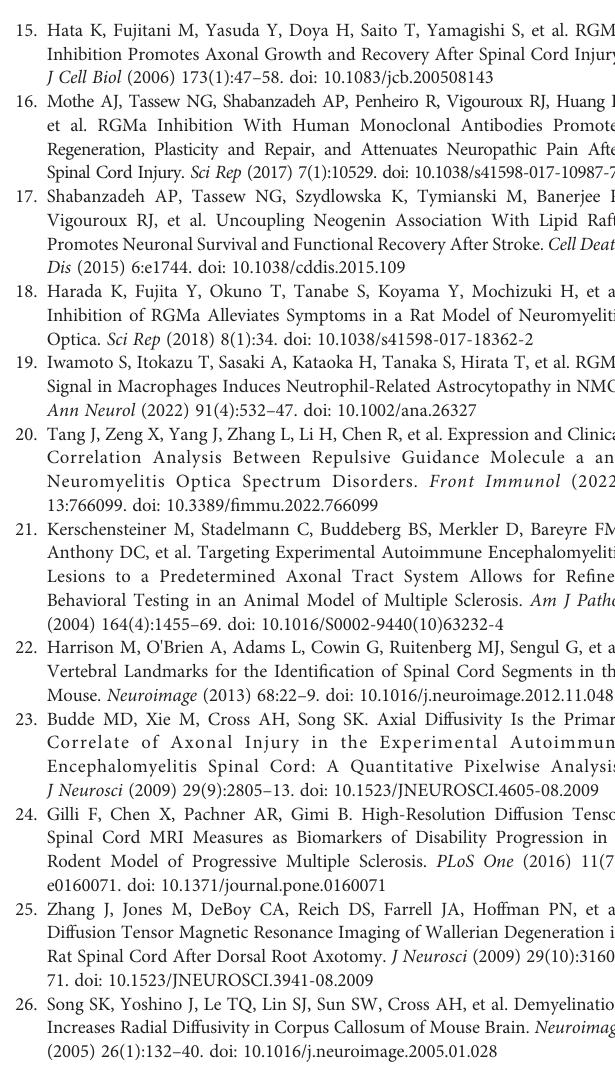
Supplementary Figure 1 | MRI data related to -. (A – H) Temporal change of the MRI parameters of each mouse. (A-D) Non-treatment group (n=4). %Gd leakage (A) , %FA positive area (B) , %AD positive area (C) , and %RD negative area (D) are shown. Isotype control and anti-RGMa antibody treatment group ( E – H , n=9-10). % Gd leakage (E) , %FA positive area (F) , %AD positive area (G) , and %RD negative area (H) are shown. (I – L) The correlation between clinical score and MRI parameters for all time point. Each plot shows individual values of clinical score and MRI parameters (pre-treatment; n=19, isotype control; n=18, anti-RGMa; n=20). % Gd leakage (I) , %FA positive area (J) , %AD positive area (K) , and %RD negative area (L) are shown. The correlation coef fi cient and signi fi cance are expressed as r and p , respectively (Spearman ’ s correlation analysis). Supplementary Figure 2 | Heatmaps of core enrichment cell marker genes. Heatmap of CNS cell markers which signi fi cantly enriched by anti-RGMa antibody treatment were shown. (A) Upregulated cell markers, (B) Downregulated cell markers of each group were expressed with Z score. Supplementary Figure 3 | Heatmaps of BBB enriched tight junction and transporter. Heatmap of BBB enriched Tight junction and transporter were